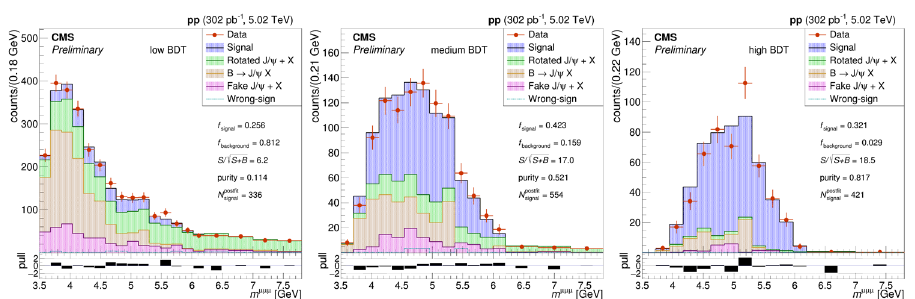
Figure 1. Template fit of the trimuon mass distributions in the three BDT bins, for the pp data sample integrated over the kinematic bins [20]. The pull between data and the fitted distributions is also shown.